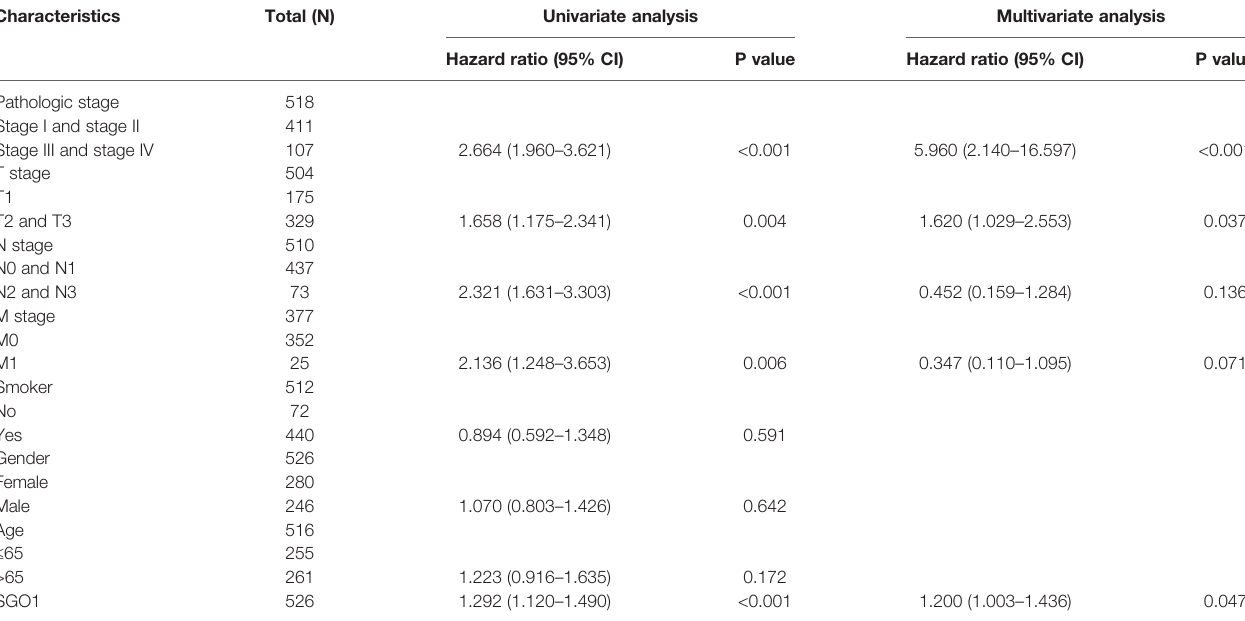
TABLE 3 | Univariate and multivariate Cox regression analyses of different parameters on overall survival in LUAD. Characteristics